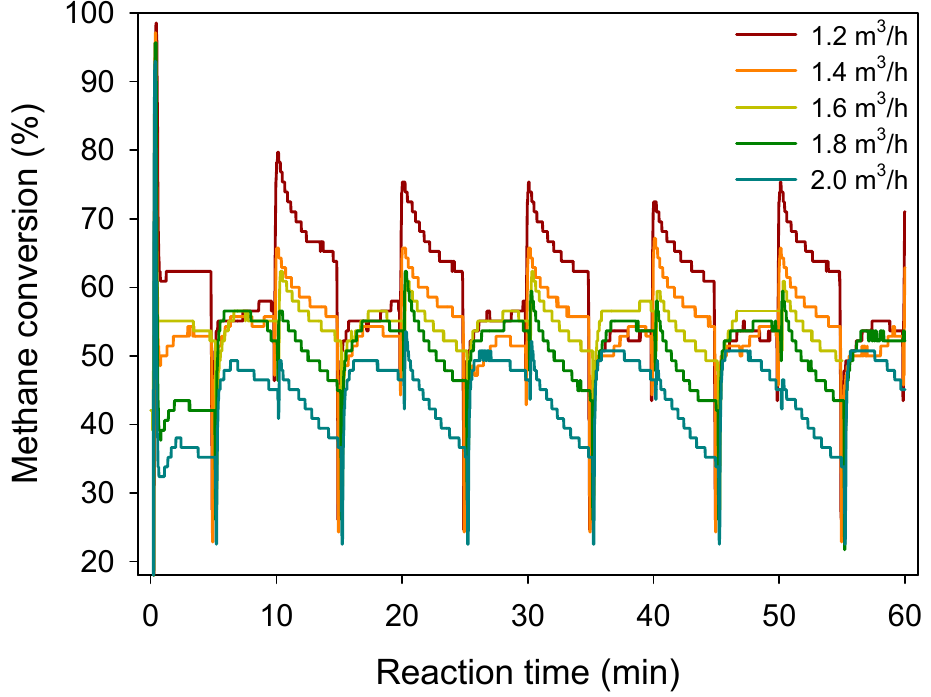
Figure 7. Methane conversion of La 0.8 Sr 0.2 MnO 3 catalyst with different methane inlet velocities. Start- up conditions: methane inlet concentration: 0.7%, reaction temperature: 800 °C, inlet flow velocity: Start-up conditions: methane inlet concentration: 0.7%, reaction temperature: 800 ◦ C, inlet flow velocity: 1.2 m 3 /h, switch time: 5